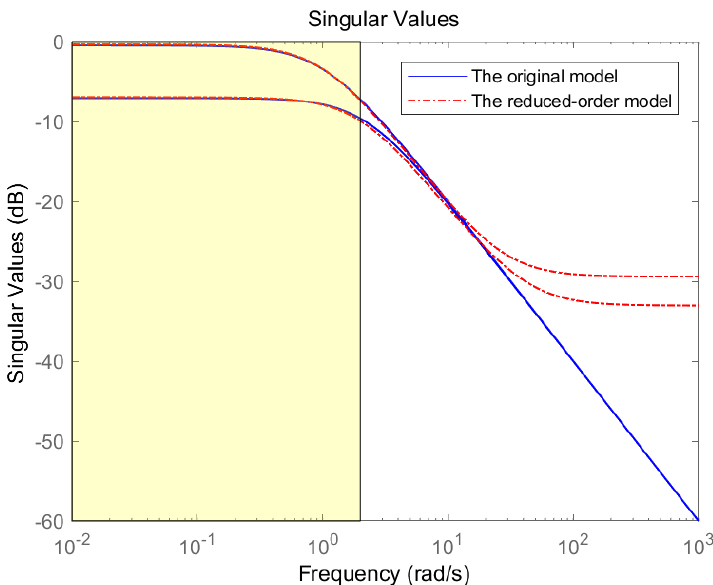
Figure 2. Singular value curves of the original and reduced-order systems.